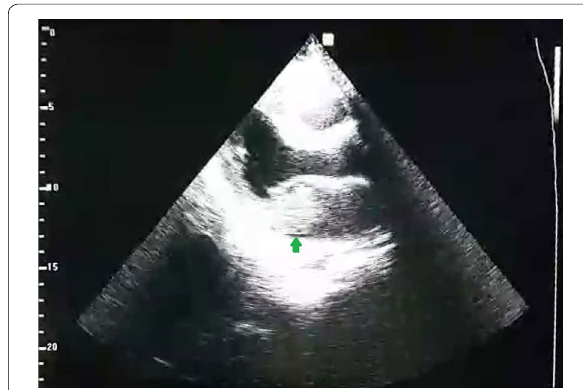
Fig. 1 Transthoracic echocardiography showed a large hyperechoic lesion, located in left atrium in the systolic phase (arrow)